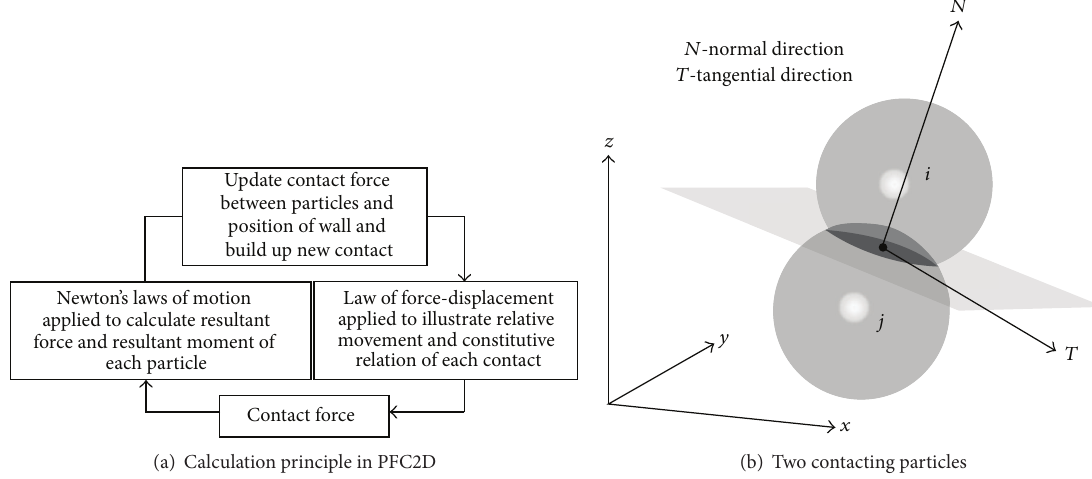
Figure 5: Contact force between particles and calculation